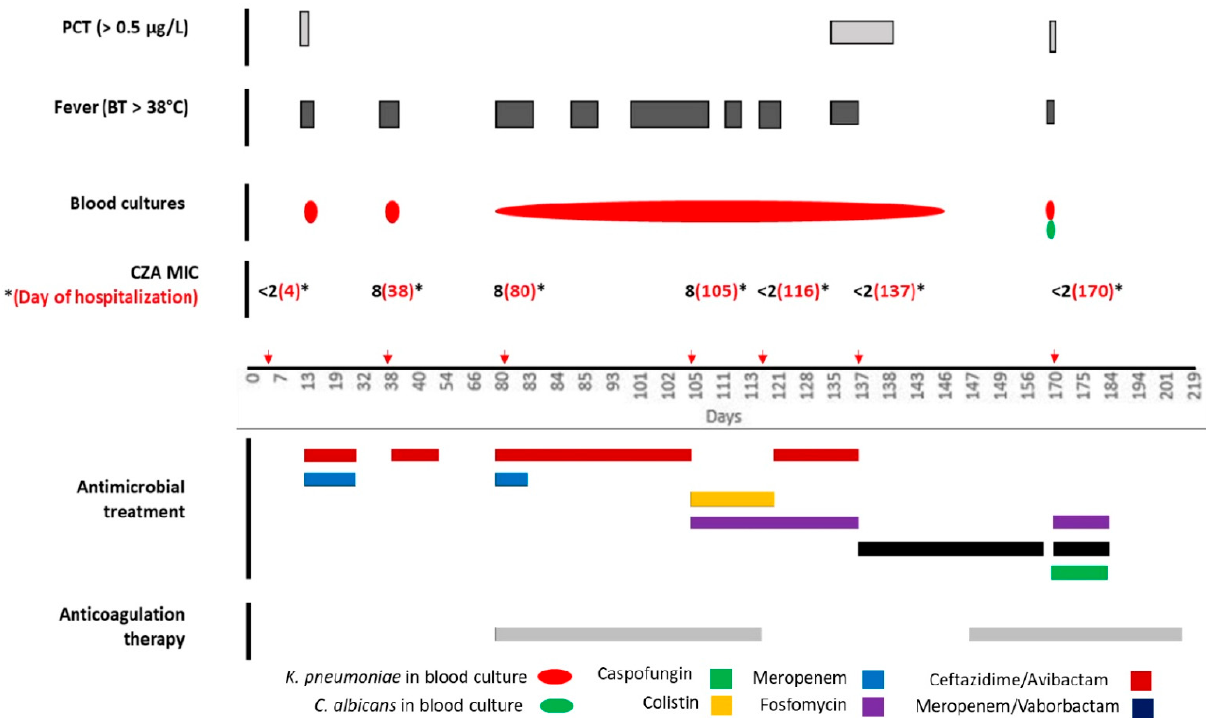
Figure 1. Timeline of the clinical, microbiological, and therapeutic course of the case. PCT: procalcitonin; BT: body temperature; CZA: ceftazidime/avibactam. Red arrows represent the exact day of KPC-Kp isolation from biological samples. The x -axis is not uniformly proportioned on purpose, since the extreme complexity of the case forced us to skip the correct proportion of days.